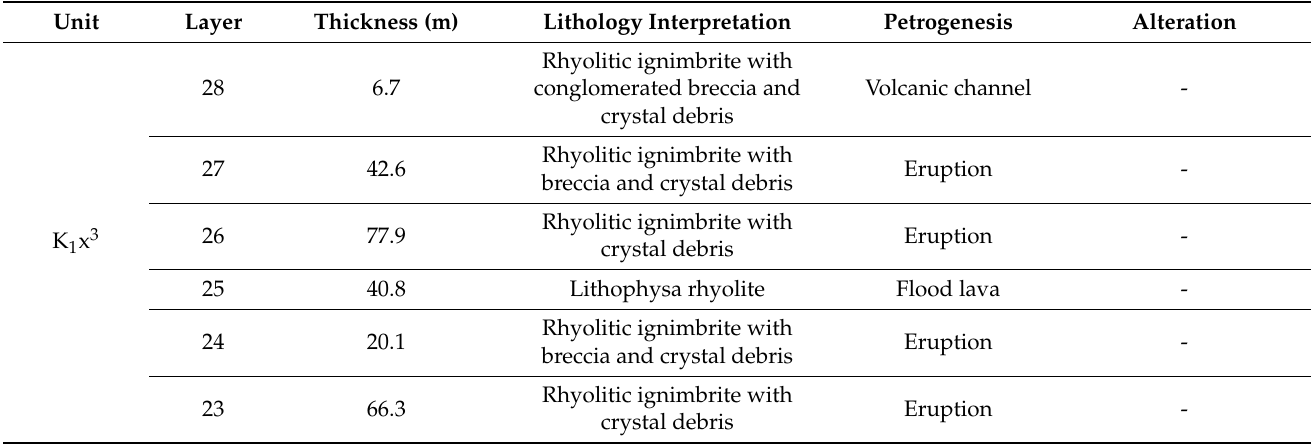
Table 1. The stratigraphic and petrogenesis result of Qishan